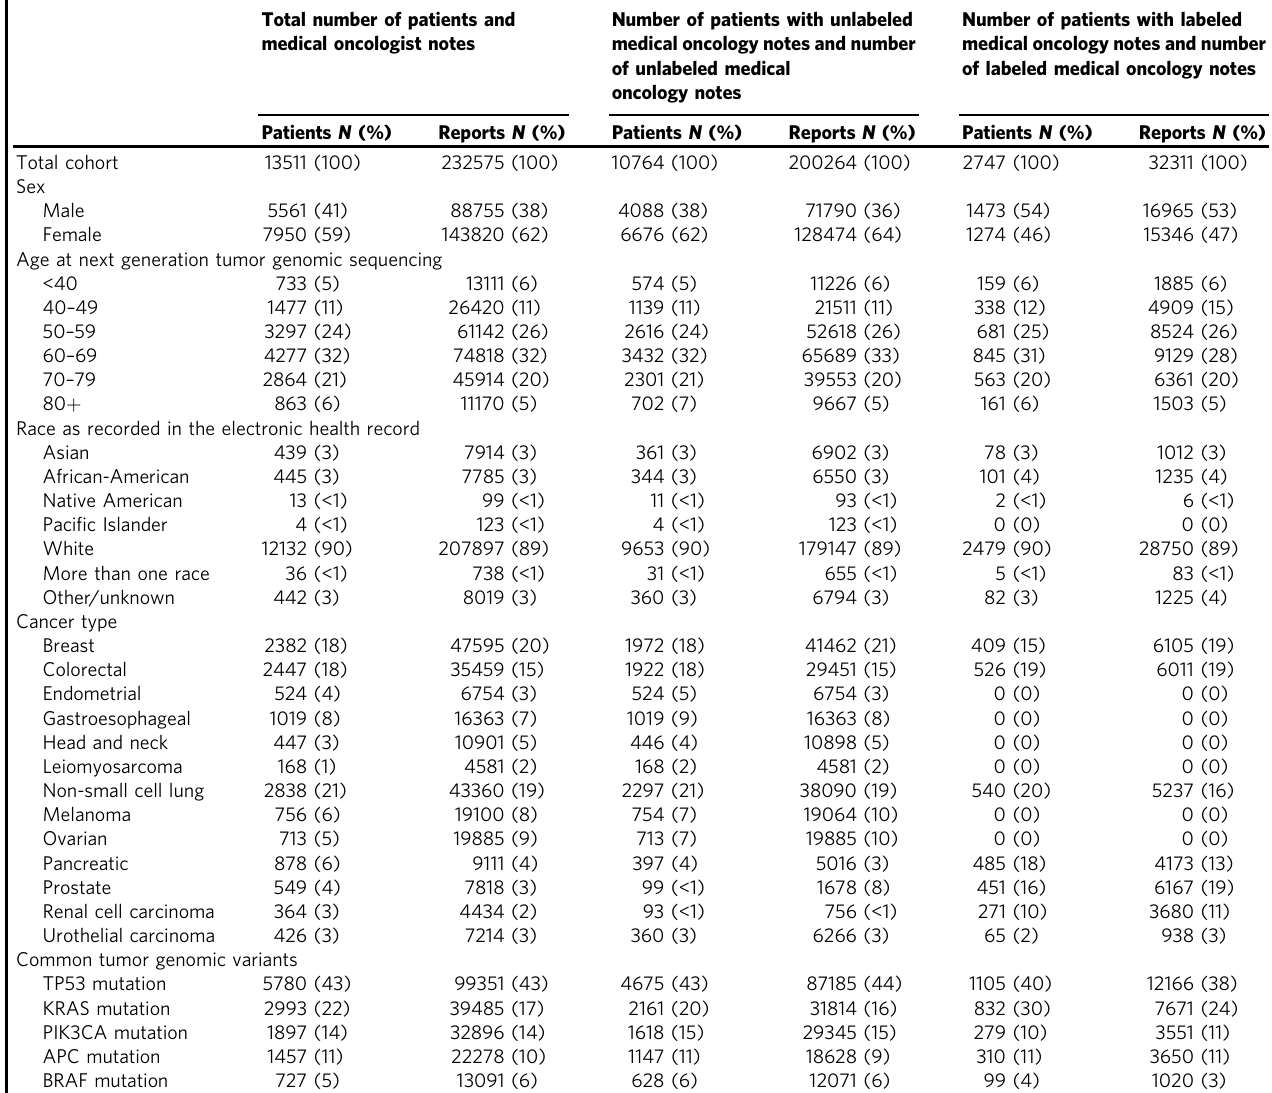
Number of patients with labeled medical oncology notes and